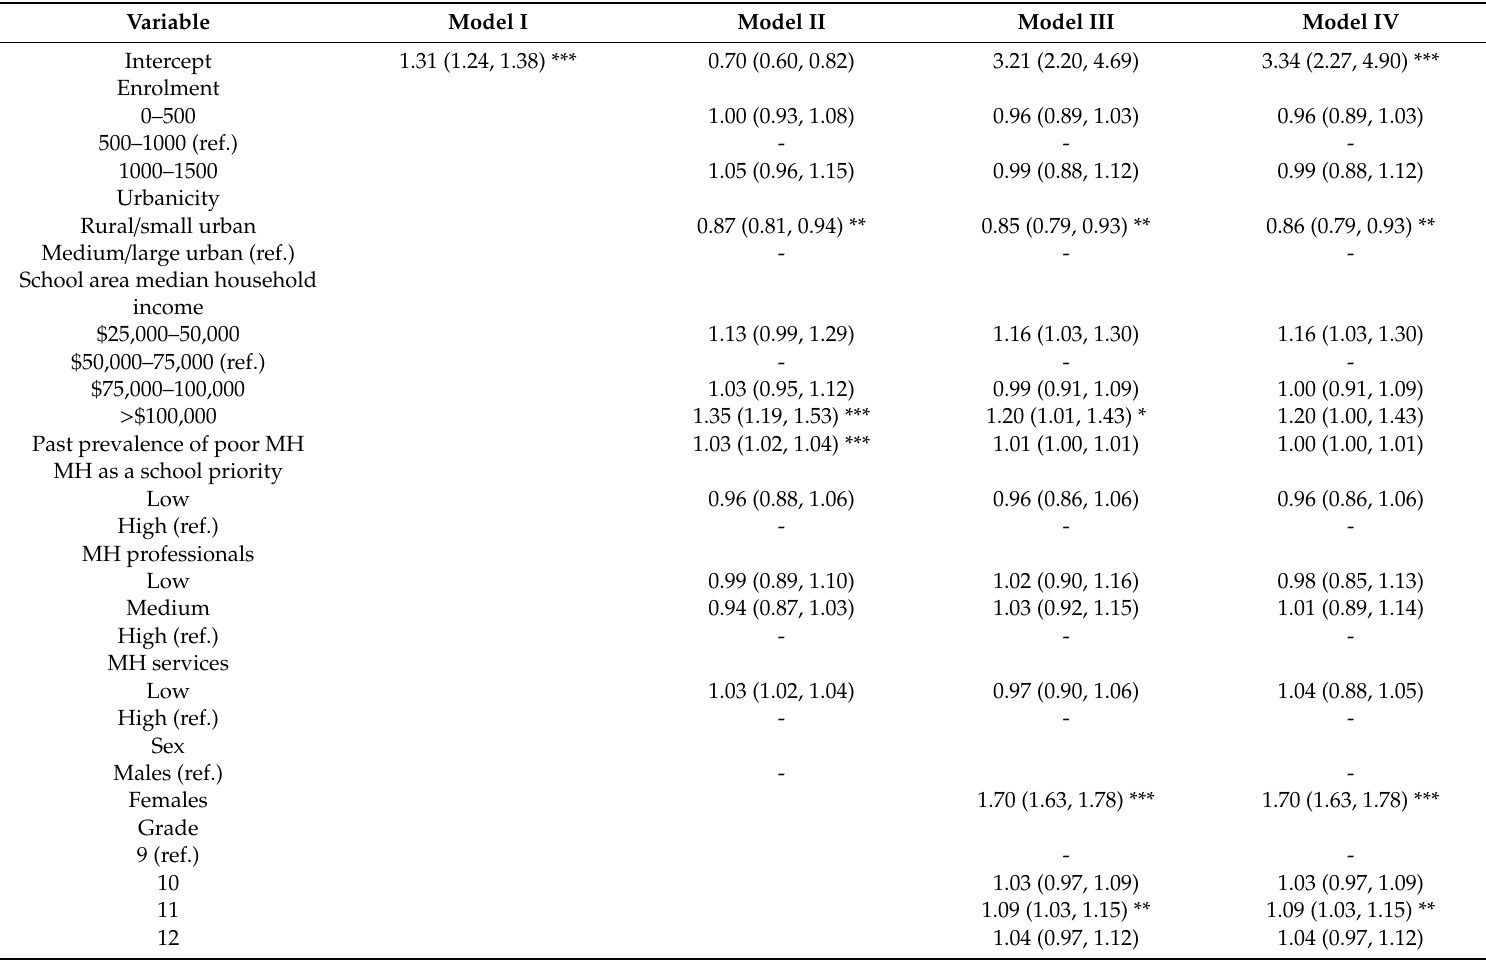
Table 3. Adjusted odds ratio estimates for endorsing reluctance towards help-seeking using generalized equation estimation